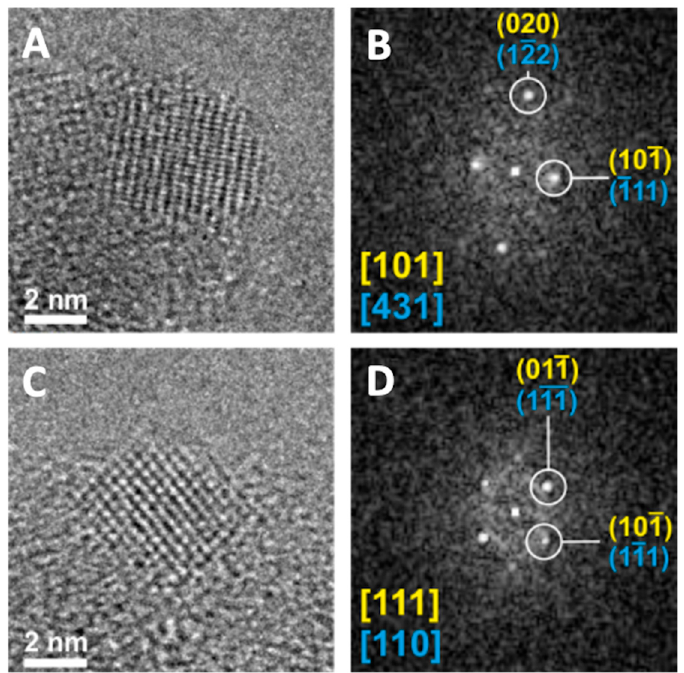
Figure 5. HRTEM: Crystal structure analysis of individual TiO 2 NPs in the aggregates. ( A , C ) HRTEM images and ( B , D ) respective fast Fourier transforms (FFTs) of zone-axis oriented selected particles. The observed structures can be attributed to anatase (yellow annotations) or to brookite (cyan annotations).